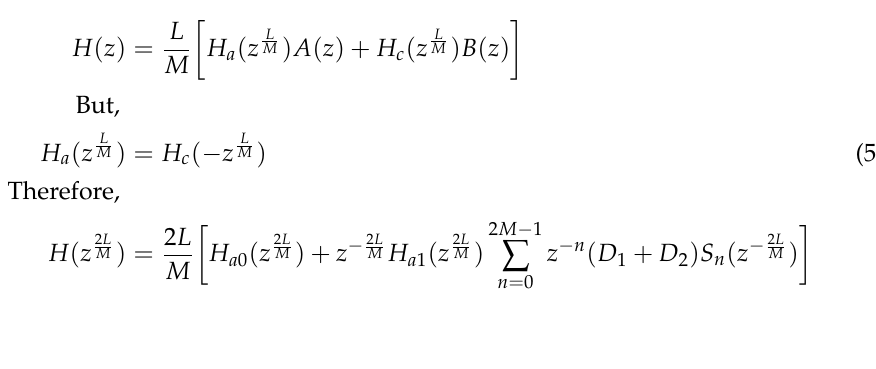
Figure 4. Diagram depicting HFarrow channelisation algorithm. The transfer function of the FRM coefficient decimation filter is given using Equation